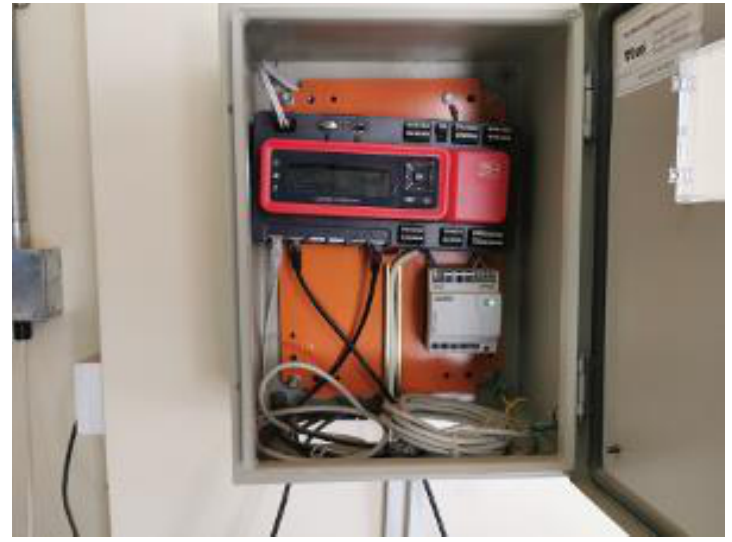
Figure 10. SMA cluster controller at the Solar Car Parking Station.